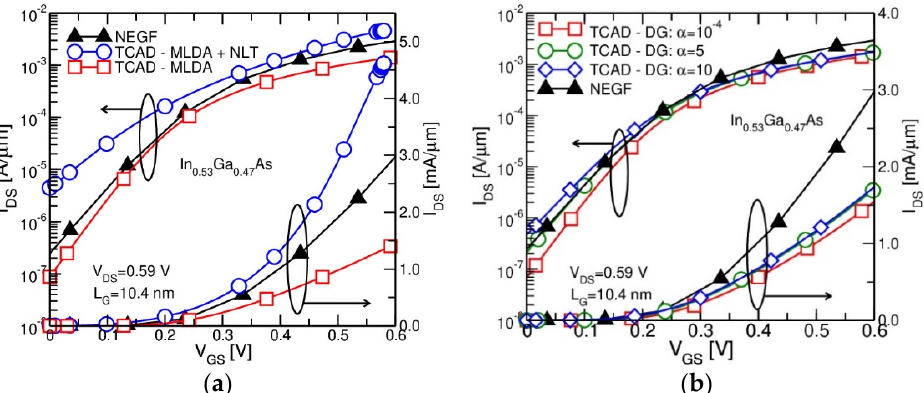
Figure 13. Comparison between TCAD and NEGF simulation results for the 10.4 nm device of Figure 4. In plot ( a ), the MLDA (Modified Local Density Approximation) is used in TCAD to describe quantization in the vertical direction and non-local-tunneling (NLT) for source-to-drain tunneling. In plot ( b ), instead, the Density Gradient (DG) model is used with different values of the parameter α described in the